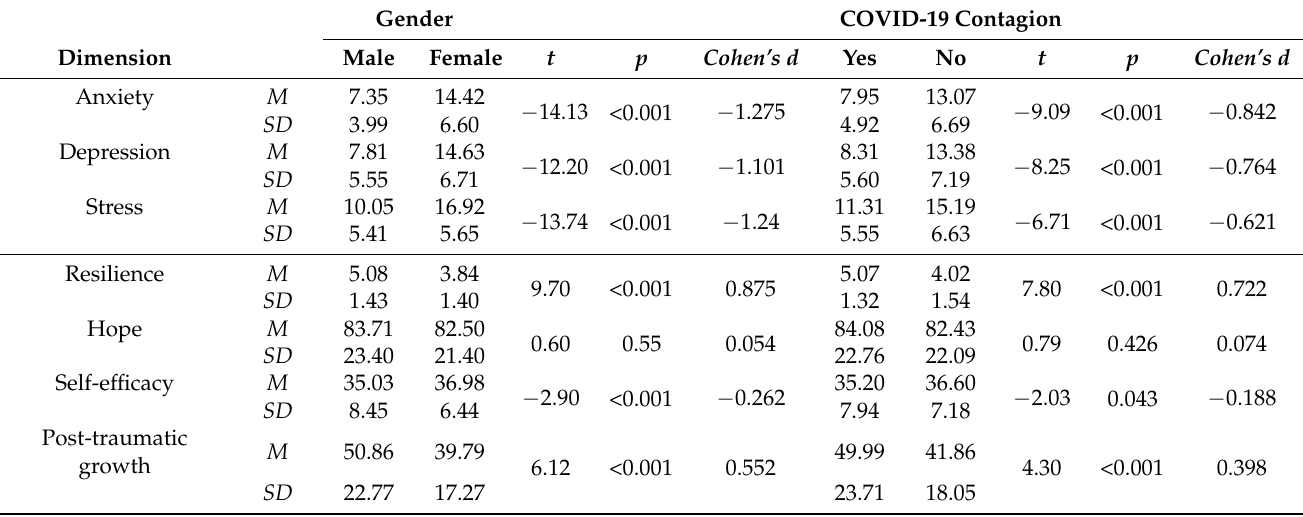
Table 2. Differences among sample from male vs. female, and from COVID-19 contagion vs.no- COVID-19 contagion on dimensions of the